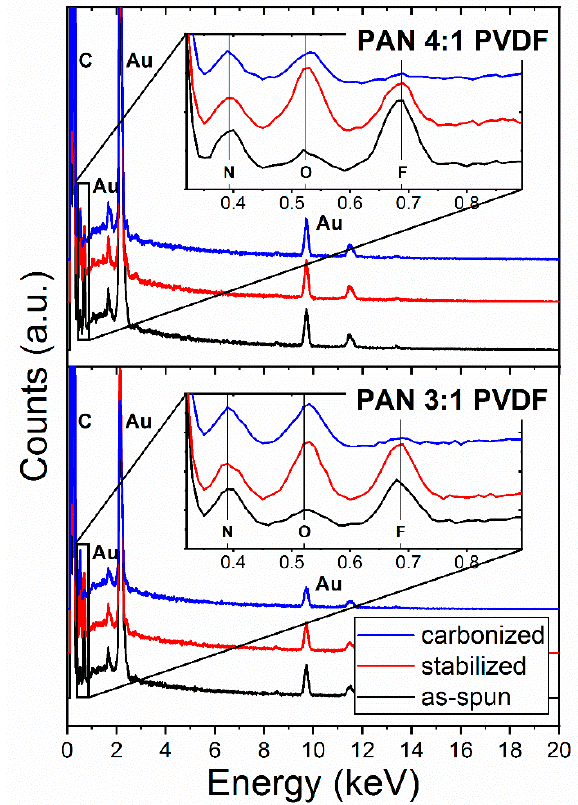
Figure 8. Normalized EDX spectra of as-spun, stabilized and carbonized blend nanofibers.